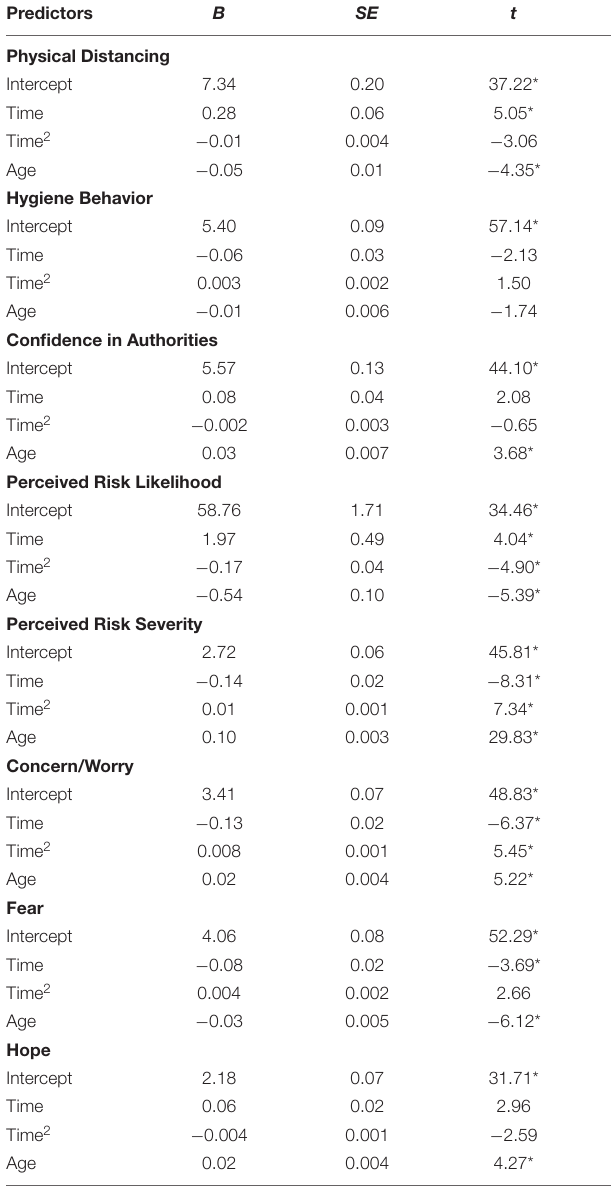
TABLE 3 | Changes in main variables over the sampling period detailed through regressing them on day of answering (linear and quadratic), controlling for participant